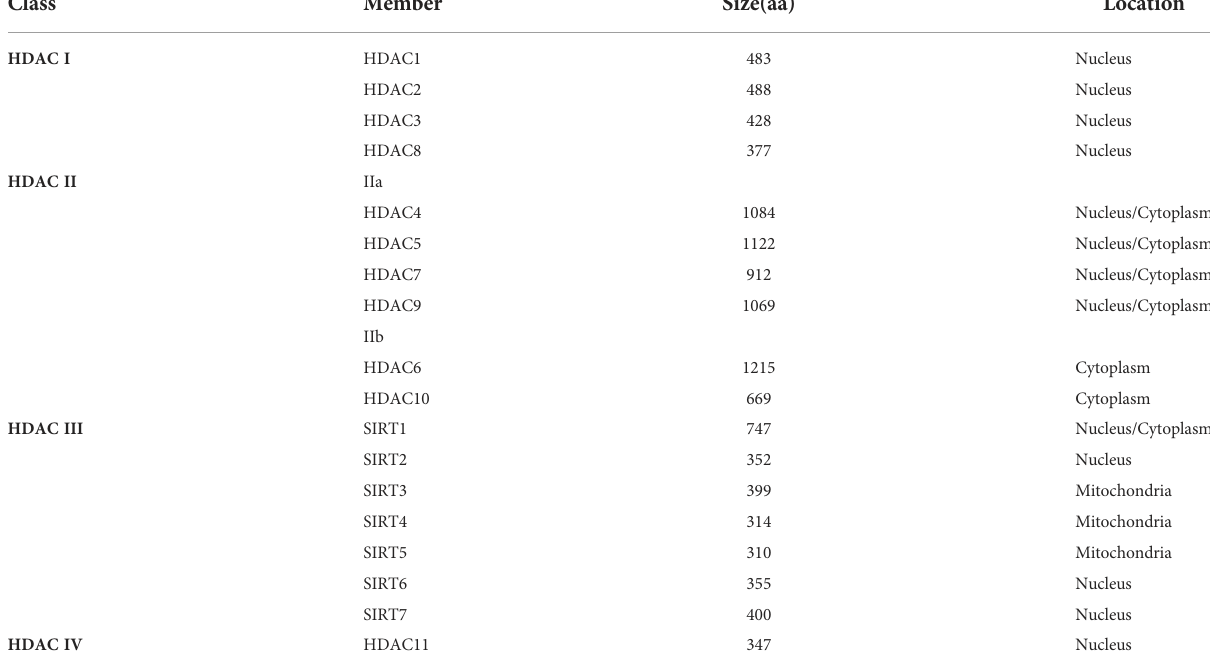
TABLE 1 Classi fi cation of